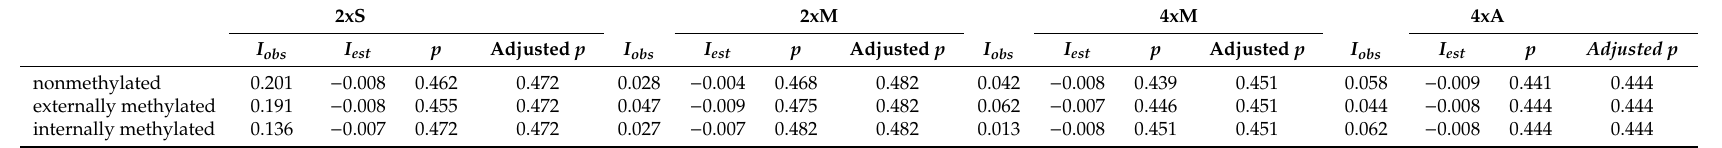
Table 4. Moran’s I values of epiloci in correlation to global spatial structure in combined groups of R. kuepferi